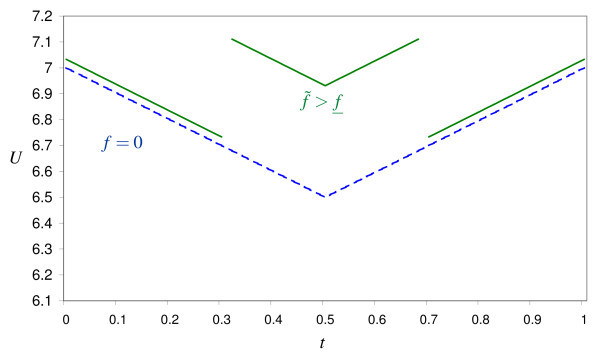
Utility distribution for f = 0 and f>f¯(Ū=10, c = 2, a = 1, θ = 10%, f˜=1.67, f¯=1.16).